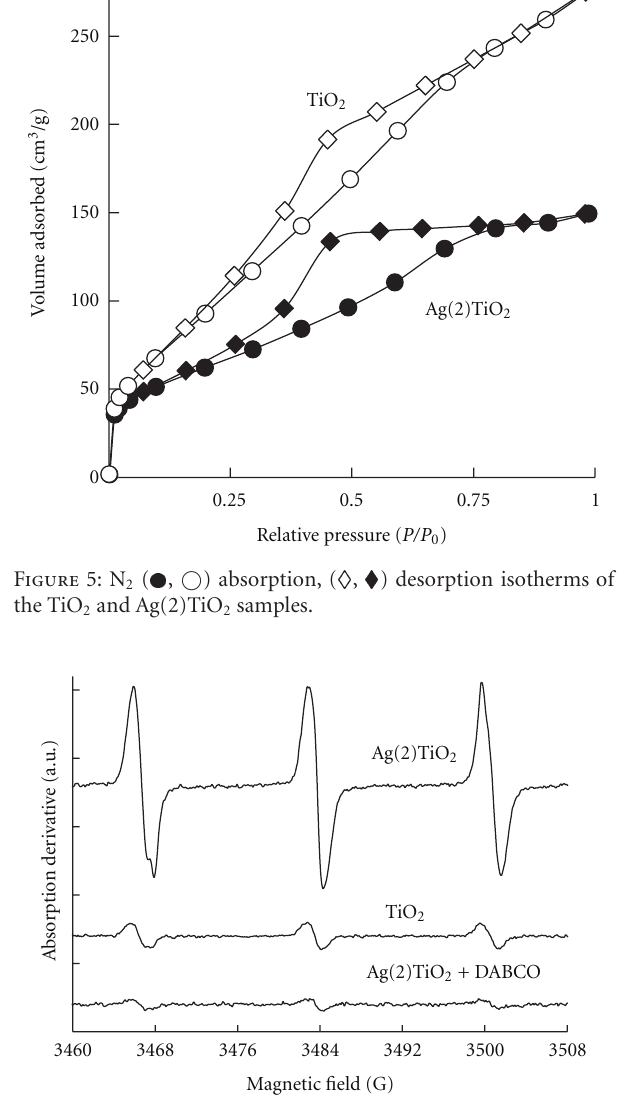
Figure 6: EPR spectra of D 2 O suspensions of Ag(2)TiO 2 and TiO 2 with TMP-OH and DABCO after 80 min of visible light